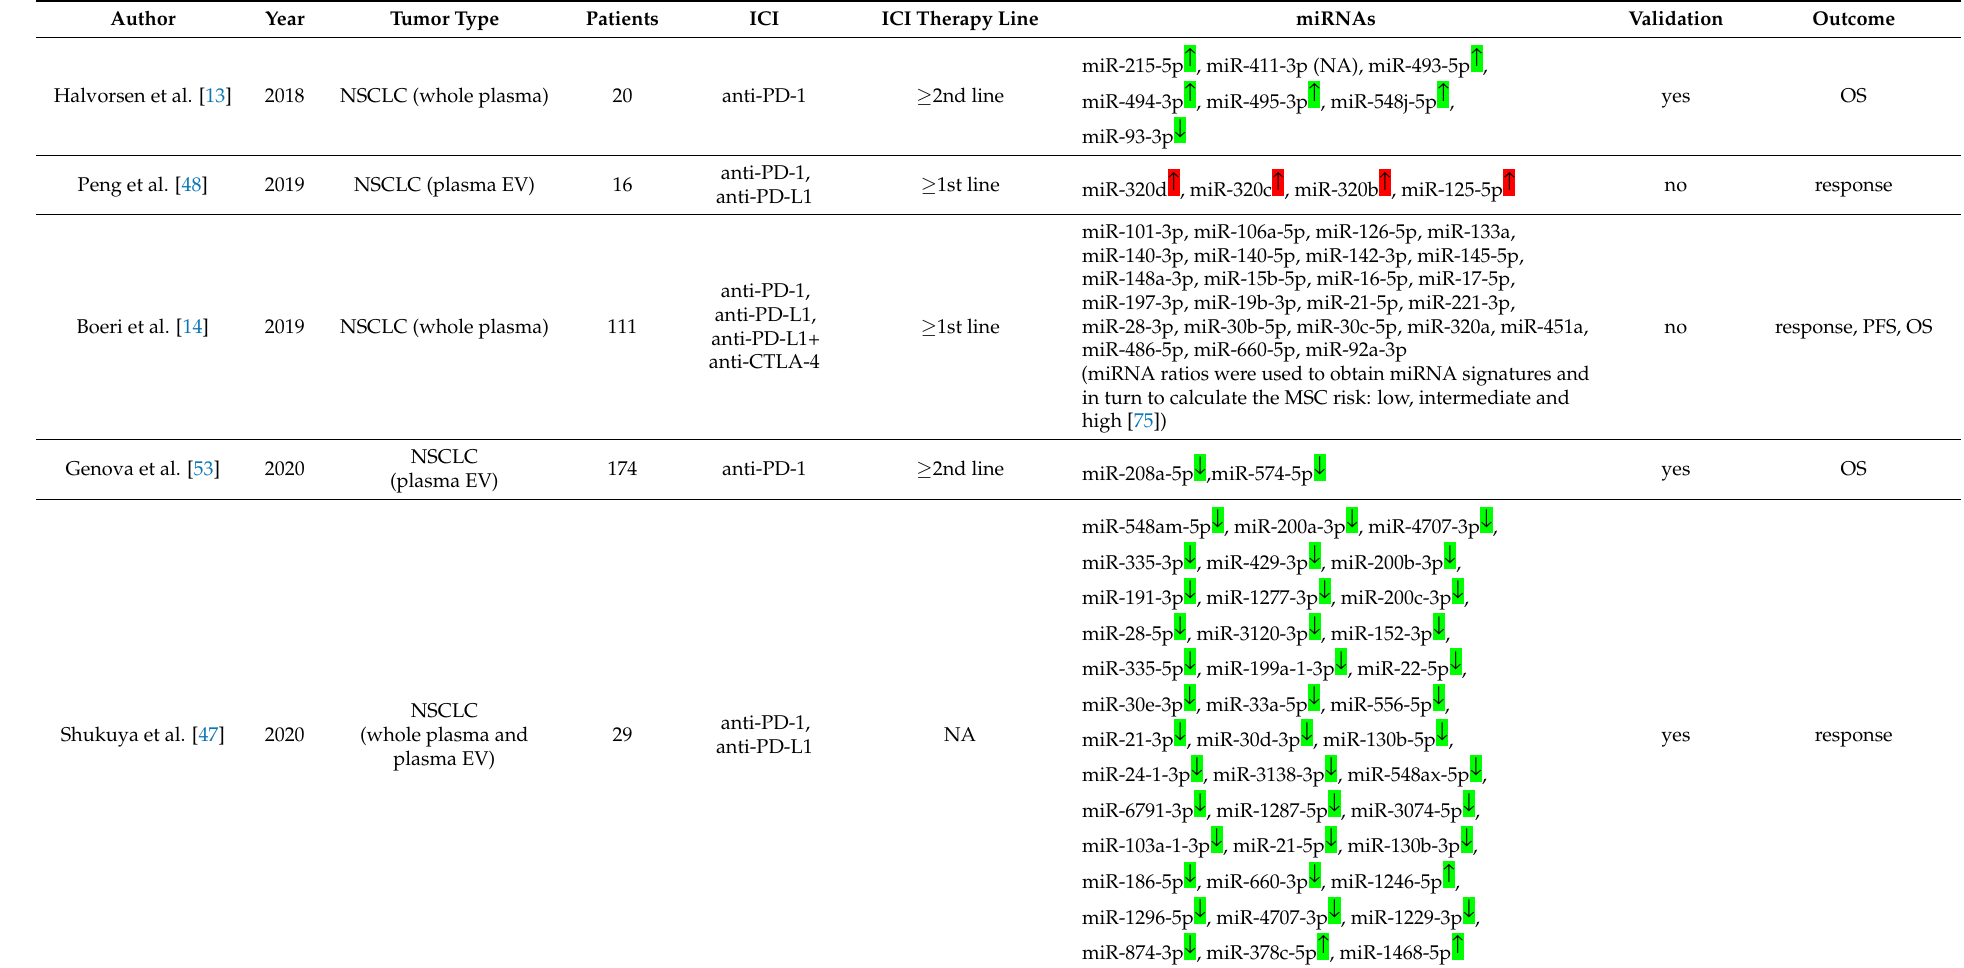
Table 1. Studies investigating microRNAs (miRNAs) as predictors of clinical outcome during the immune-checkpoint blockade.